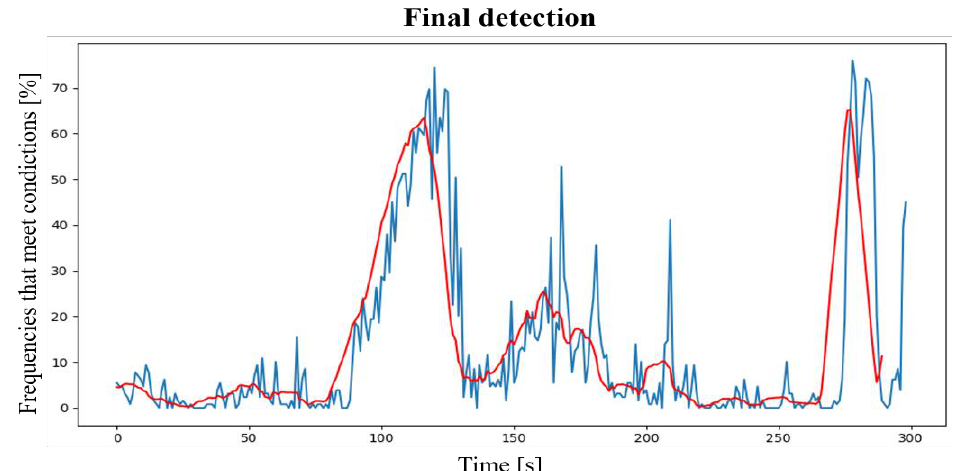
Figure 9. Percentage of detection over time.